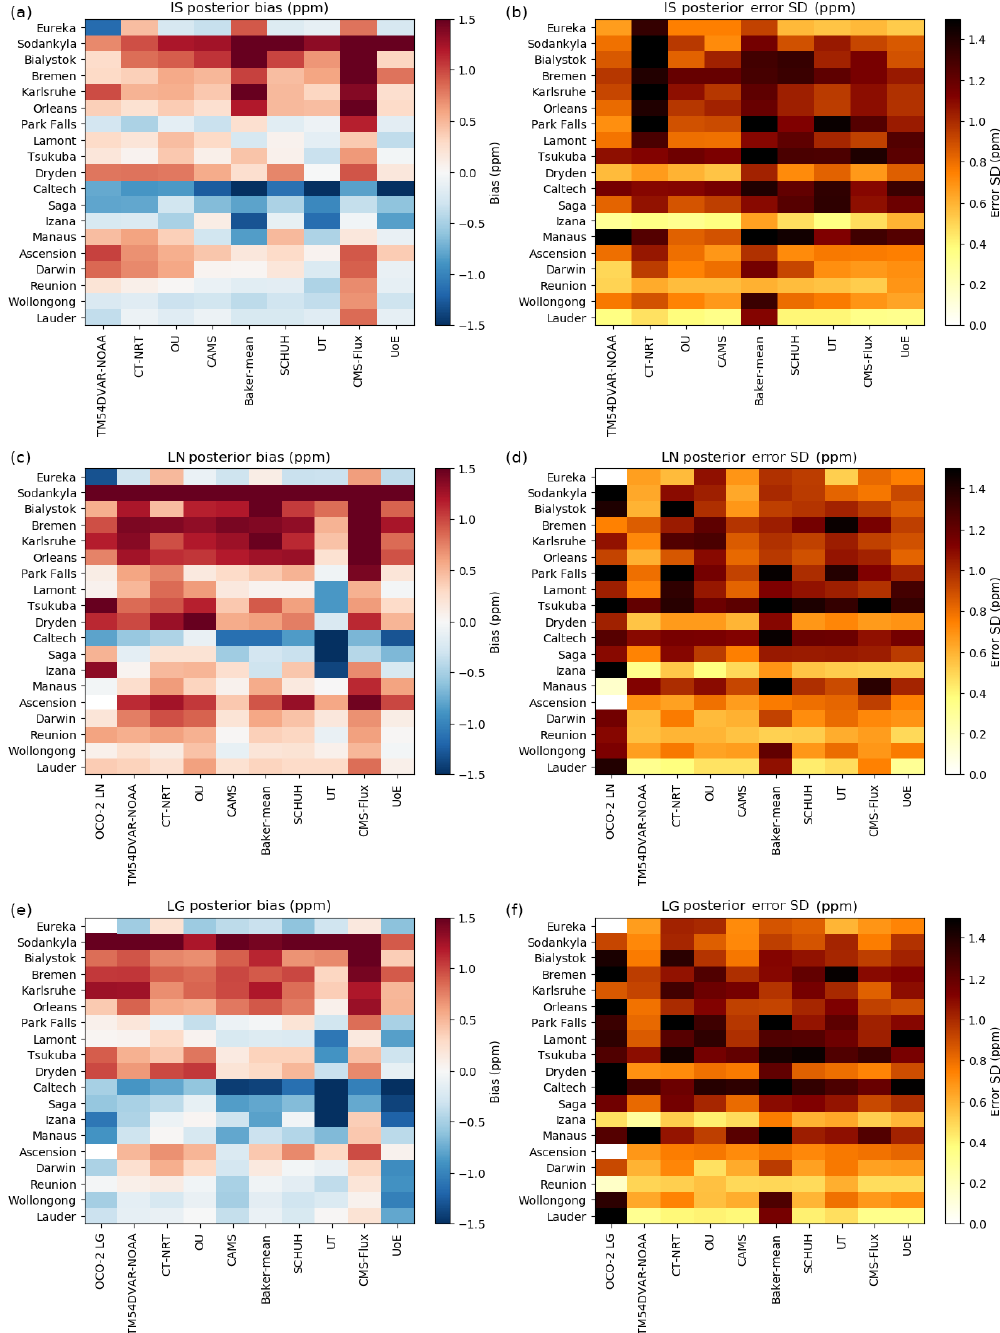
Figure 8. Bias (a, c, e) and standard deviation (b, d, f) for all TCCON sites by model (ordered by latitude). Statistics are computed from all residuals: simulated – retrieved X CO . For the OCO-2 LN (c, d) and OCO-2 LG (e, f) statistics, the first column depicts the statistics for the 2 residuals between collocated OCO-2 10s values and TCCON retrievals. Of note is the correlation between the bias in the OCO-2 retrievals and the resultant bias in the posterior concentrations. In general, LN experiment posterior samples show a high bias relative to TCCON at all except a few sites. IS and LG show similar biases over most of the sites. According to O’Dell et al. (2018), land nadir observations are biased high by about 0.5ppm relative to land glint observations. The LN experiment also has a larger standard deviation at most TCCON sites than the IS and LG experiments. Of particular interest are the various European sites, for which all models and data constraints show a high bias relative to